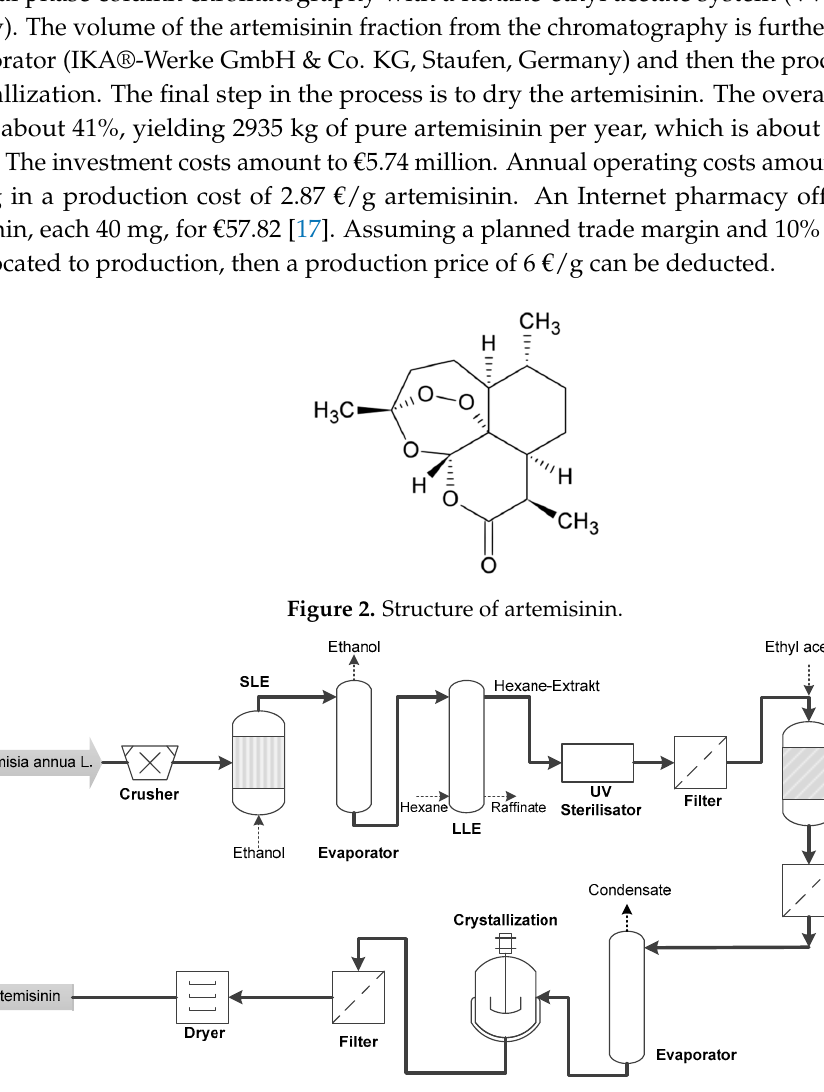
Figure 3. Flow scheme of the benchmark process, (SLE, solid-liquid extraction; UV, ultraviolet).